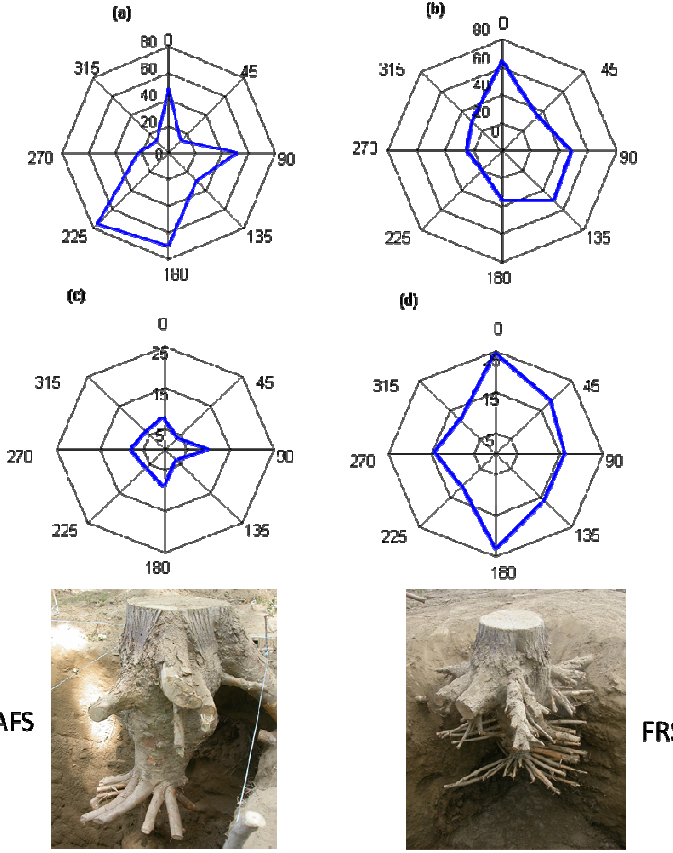
Fig. 3. Graphic and pictorial presentation of root profile in stump voxel column of AFS and FRS trees. Root cross section area is represented in (a) and (b), and Root number is represented in (c) and (d), respectively of AFS and FRS trees. 0 degree symbolizes north